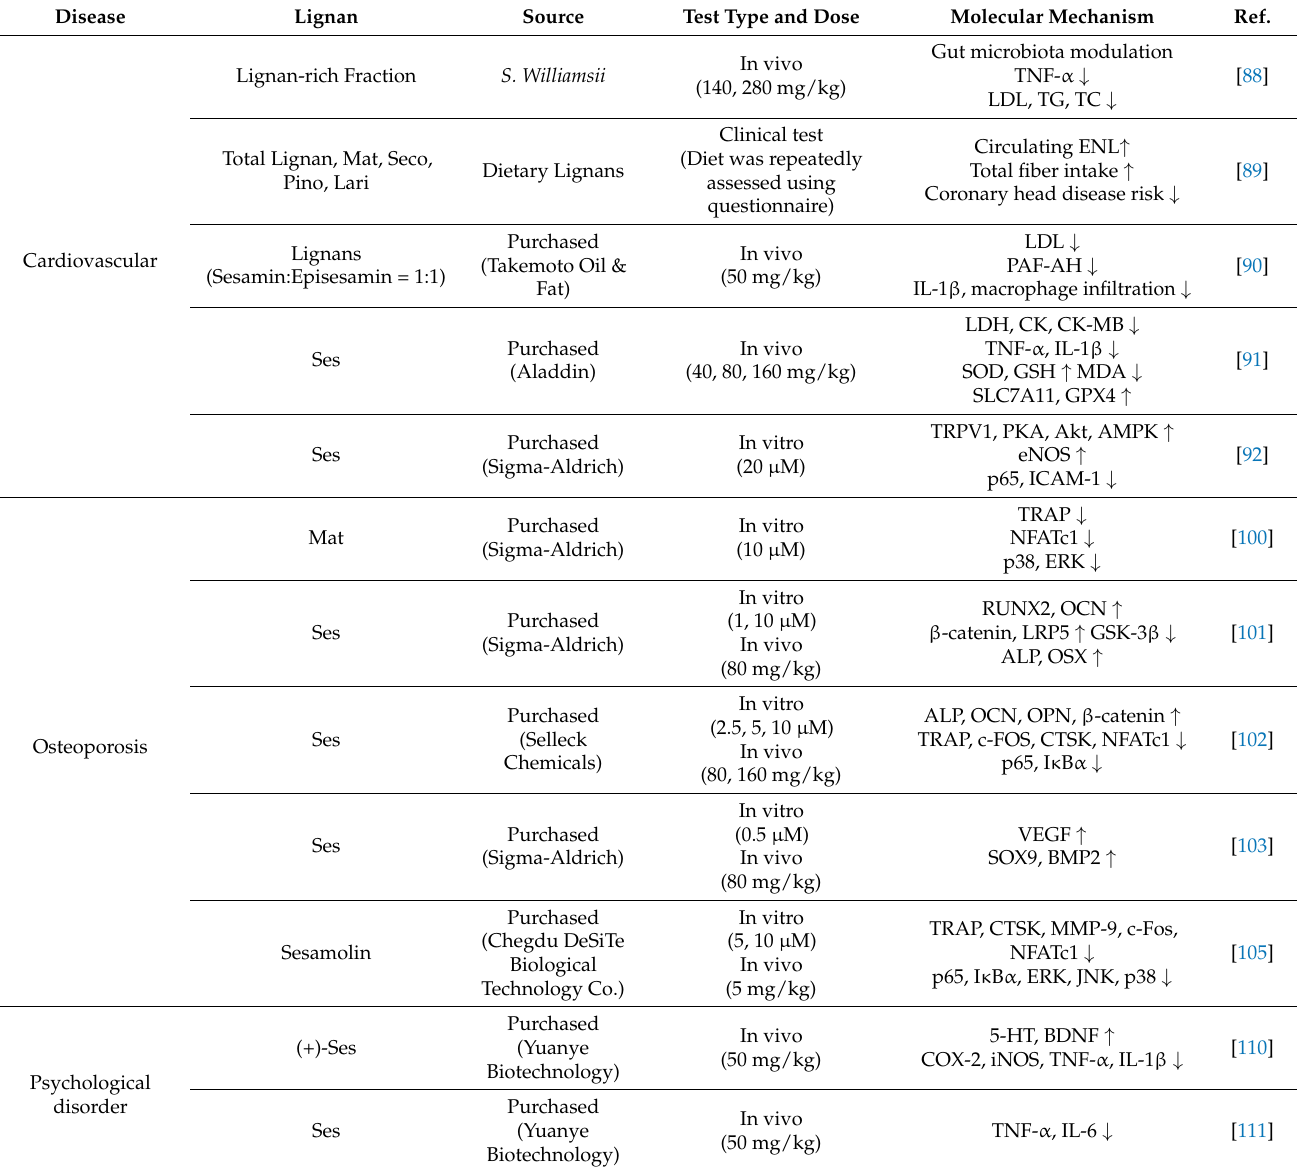
Table 1. Summary of the result of published pharmacological experiments conducted to evaluate the effects of lignans on postmenopausal